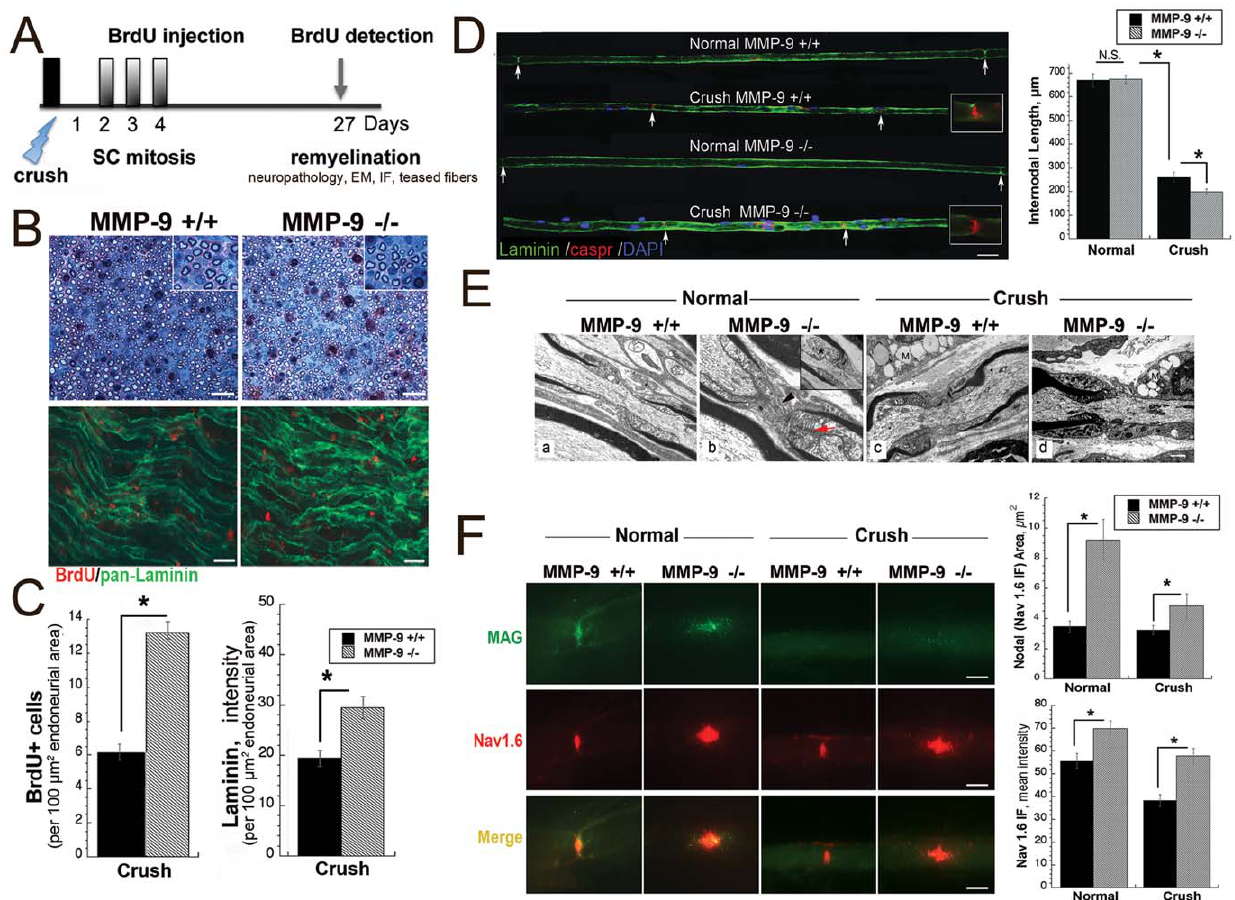
Figure 6. Remyelinated nerves of MMP-9 KO mice exhibit more SCs, short internodes and aberrant Na v 1.6 clusters. A, A schematic of BrdU administration (100 mg/kg, i.p.) at days 2–4, followed by BrdU detection during remyelination (day 27 post-crush). B, Methylene blue Azure II staining of transverse araldite-embedded nerves at day 27 post-crush, the crush site (top panel). Effective remyelination in MMP-9 + / + and MMP-9 2 / 2 mice (representative of n=3/group). Immunostaining for BrdU (red) and laminin (green) after A. (bottom panel); longitudinal nerve section, the crush site, day 27 post-crush. Increased number of cells that incorporate BrdU at days 2–4 post-crush remain in remyelinated nerves in MMP-9 2 / 2 mice (representative of n=3/group). Scale bars, 50 m m. C, The mean BrdU + cell counts and pan-laminin staining from B. 6 SEM in n=4/group (*, p , 0.05). D, Teased fibers in normal and remyelinated (day 27 post-crush) nerves in MMP-9 + / + and MMP-9 2 / 2 mice: immunofluorescent staining for laminin a2 (green), Caspr (red) and DAPI (blue). The distance between two arrows represents a myelin internode. The graph represents the mean internodal length ( m m) 6 SEM presented in A (*, p , 0.05). N.S., not significant. Scale bars: A, 30 m m (insets, 1200 6 magnification). E, Electron microscopy of the nodes of Ranvier and the adjacent paranodes in normal and remyelinated (day 27 post-crush) nerves in MMP-9 + / + and MMP 2 / 2 mice. (a), Paranodal loops in contact with the axolemma of a small myelinated fiber in MMP-9 + / + mouse. (b), Desmosomal junctions between adjacent paranodal loops (arrow) and nodal microvilli (arrowhead) in MMP-9 2 / 2 mouse. Inset shows a heminode with an axon-SC network (asterisk) in the juxtaparanodal region. (c), The lipid-laden macrophages (M, upper left) in the crushed nerves of MMP-9 + / + mouse. (d) The heminode (left) is myelinated in the crushed nerve of MMP-9 2 / 2 mouse. The lipid-laden macrophages in close contact with the axolemma in the non-myelinated region (M, right).